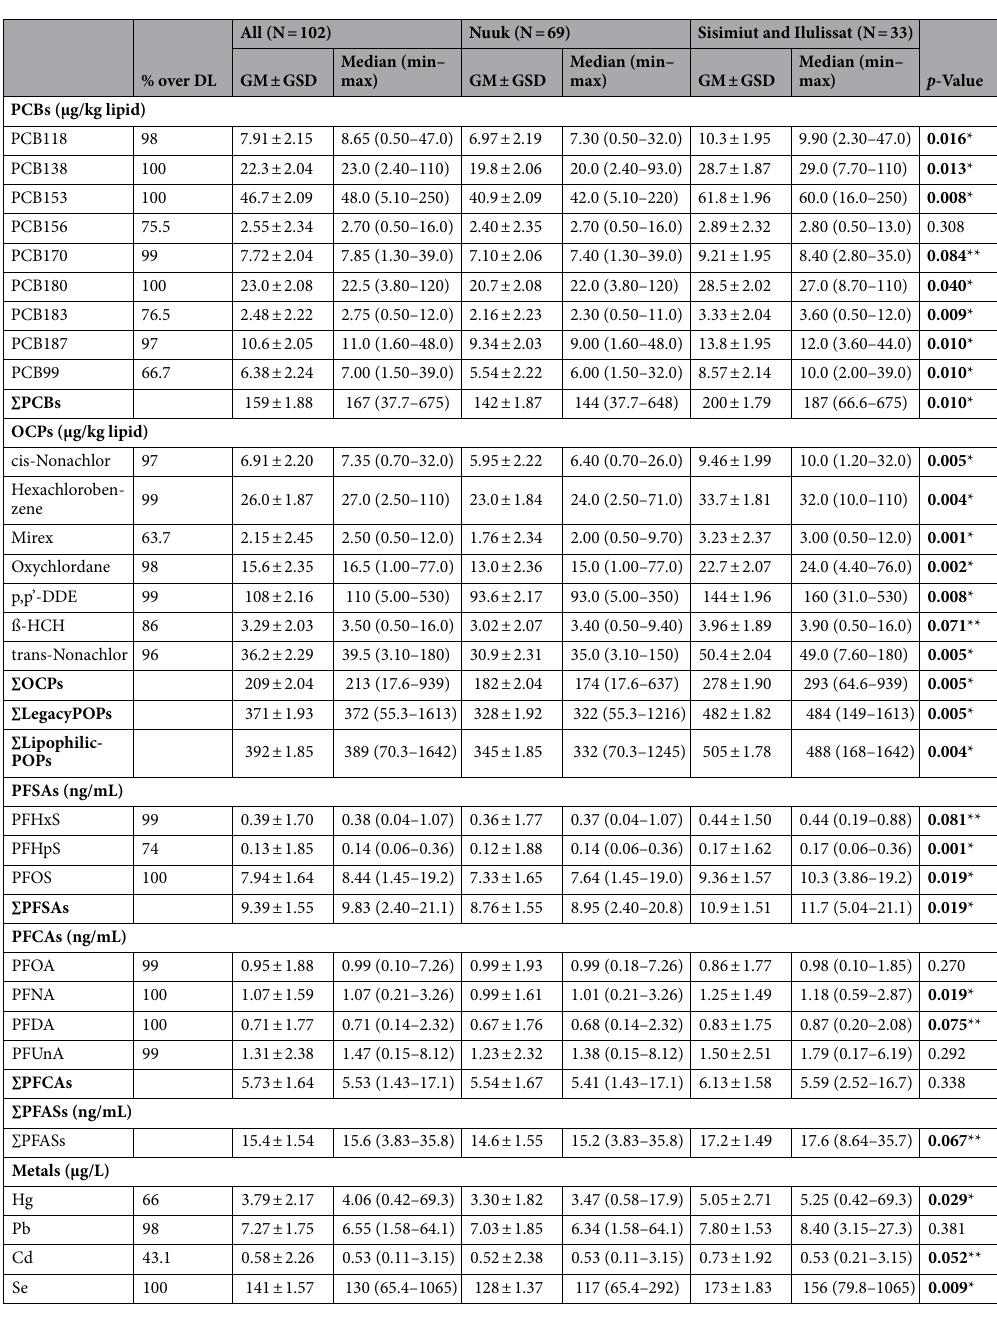
Table 3. Concentrations of POPs and metals: Greenlandic pregnant women in the ACCEPT cohort 2013– 2015. N number of participants, GM geometric mean, GSD geometric standard deviation, DL detection limit, p -Values was calculated with T-test on ln-transformed data. Bold text and * = Significant ( p ≤ 0.050), Bold text and ** = Borderline significant ( p ≤